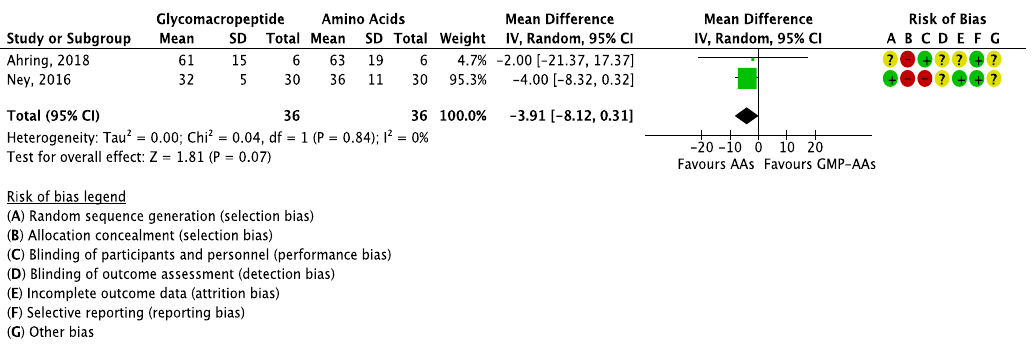
Figure 5. Forest plot of studies with data on glycomacropeptide interventions on blood tyrosine levels. The analysis included data from two studies with a total of 72 participants.AAs: synthetic protein derived from L-amino acids; CI: confidence interval; df: degrees of freedom; GMP-AAs: glycomacropeptide supplemented with amino acids; IV: intravitreal; SD: standard deviation. (MD = − 0.22 mg/dL ( − 1.49, 1.04); I 2 = 0%; P = 0.73; two studies; N = 72 participants; Figure 6); nor